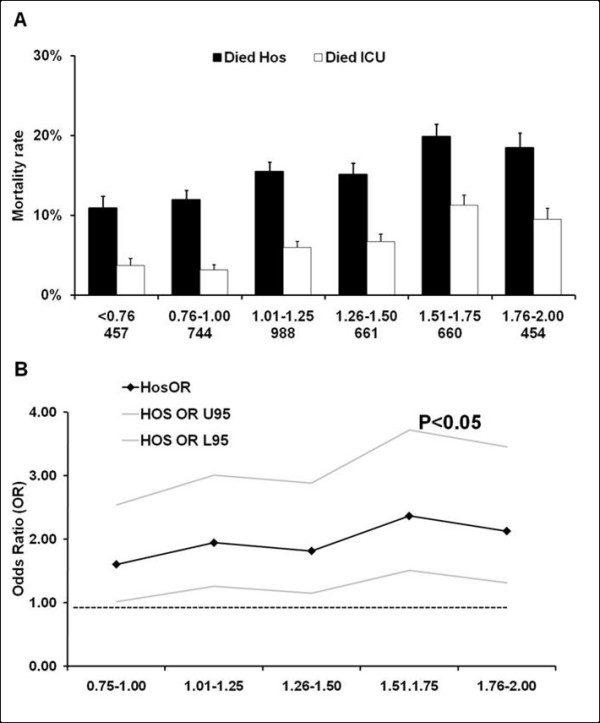
Relationship between the admission blood lactate concentration within the normal range and mortality rate. Relationship between the admission blood lactate (LacADM) concentration within the normal range and ICU and hospital mortality rate (Panel (a)). The number of patients in each group is expressed as (n). Panel (b) displays the result (adjusted odds ratios (OR) with 95% Confidence Interval (CI)) of a multivariate analysis assessing the association between admission blood lactate (LacADM) within the normal range and hospital mortality. (All ORs in the multivariate analysis are compared to the 0.00 to 0.75mmol.L-1 group with the horizontal line representing an OR of 1.0.).